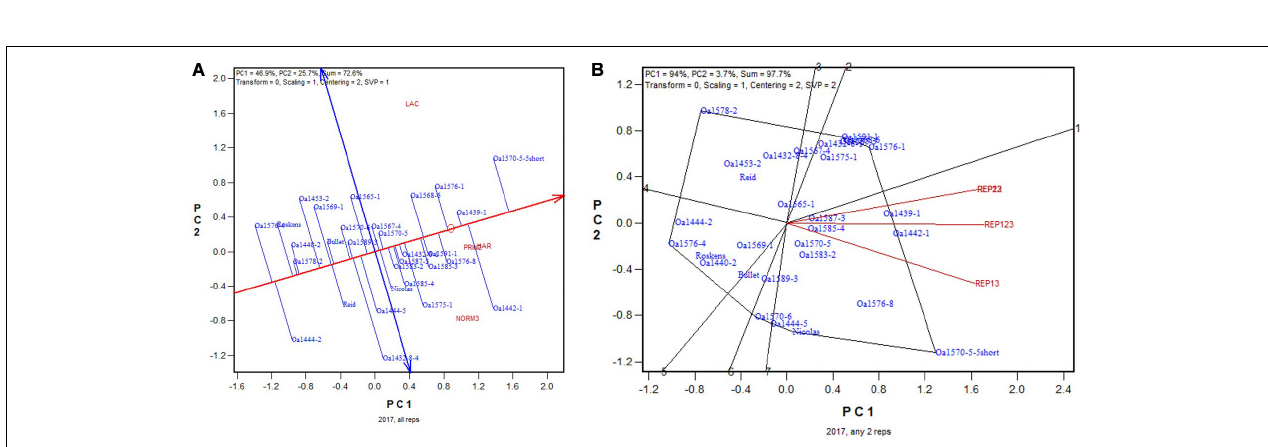
FIGURE 9 | Biplots for the 2016 non-Ontario trials. (A) GGE biplot to show genotype ranking based on data from all three replicates, and (B) summary biplot to show the genotype rankings based on all three replicates and on any two of them. REP123, genotypic ranking based on all three replicates; REP12, genotype ranking based on replicates 1 and 2; REP13, genotype ranking based on replicates 1 and 3.